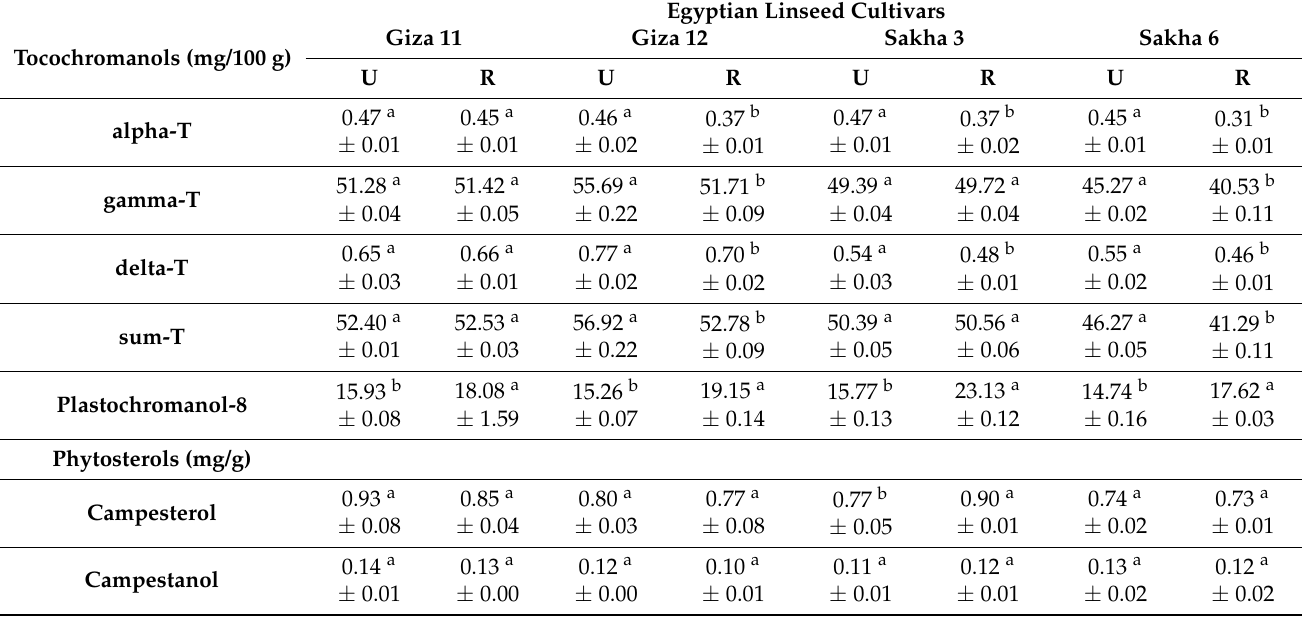
Table 6. Tocochromanol (mg/100g) and phytosterol composition (mg/g) of oil extracted from four Egyptian unroasted and roasted linseed